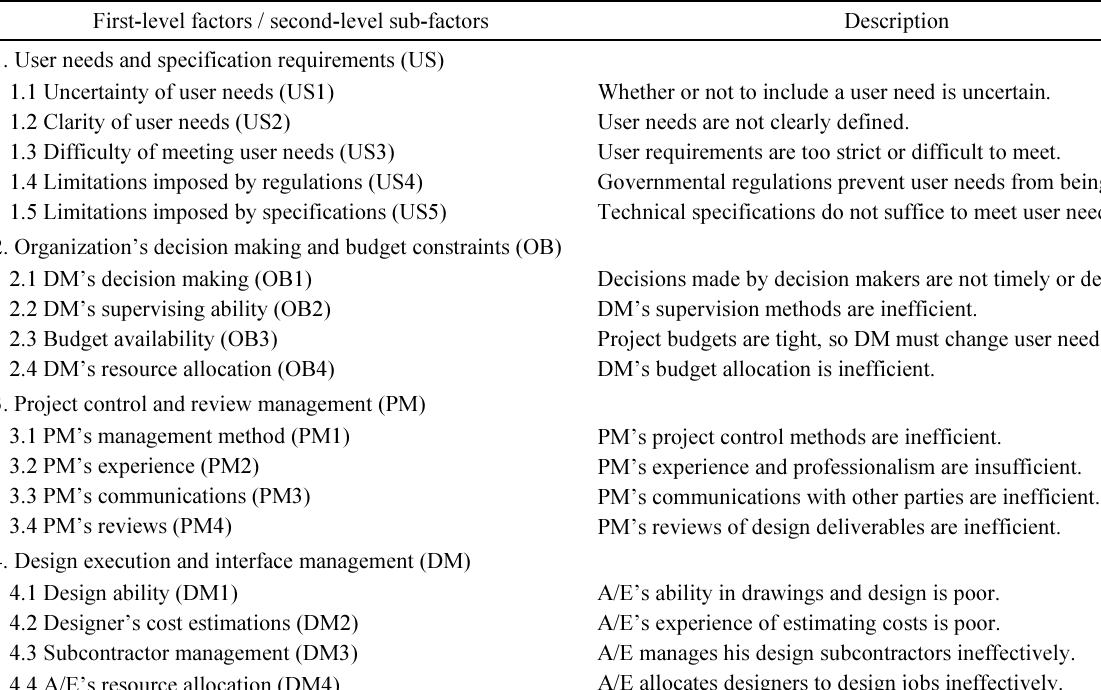
Table 2. Factors and sub-factors that affect design delays First-level factors / second-level